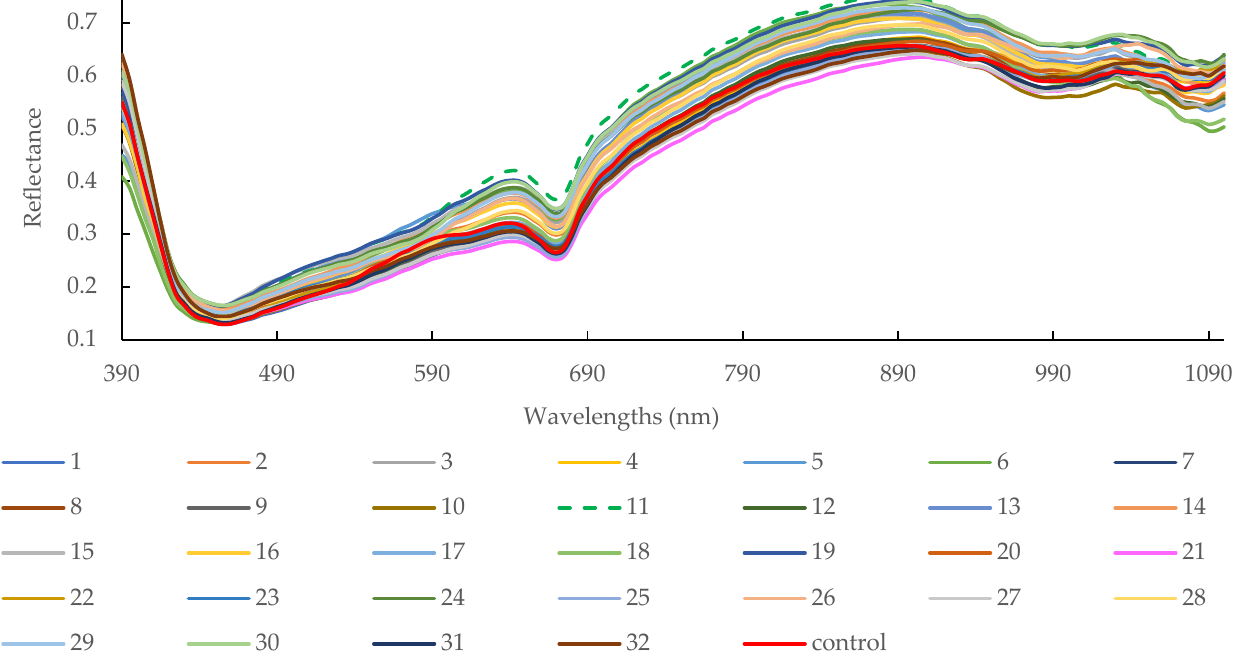
Figure 2. Mean reflectance spectral profiles of sausage cores with different casing treatments (i.e., different legend numbers) in the spectral range of 390–1100 nm.